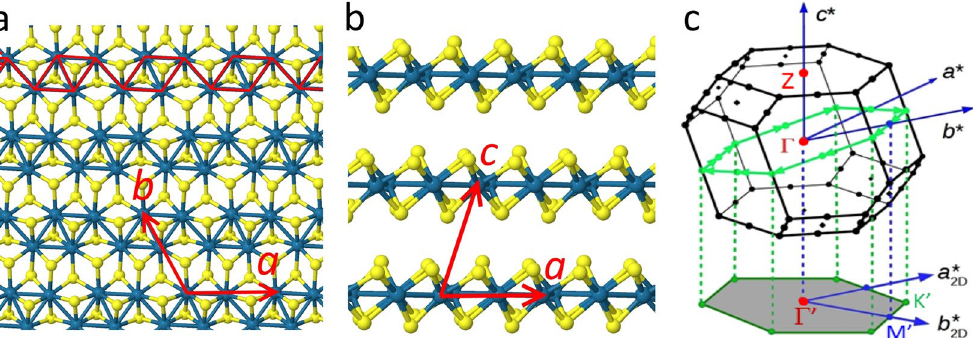
Figure 1. Crystal structure and first Brillouin zone of triclinic ReSe 2 . ( a ) View of a single layer seen from above and ( b ) from the side. Re atoms are coloured blue and Se atoms are yellow. The directions of the lattice vectors a , b and c are indicated; a is defined here as the direction of the rhenium chains, highlighted in red in ( a ). ( c ) First Brillouin zone of ReSe 2 indicating the reciprocal lattice vectors a * , b * and c * and the conventional points Γ (0, 0, 0) and Z (0, 0, ± ½). The tilted green hexagon indicates a path in reciprocal space around points of the type ( ± ½, 0, 0); the lower gray hexagon shows the pseudo-Brillouin zone defined by the projections of these points onto the real space layer plane, with basis vectors labelled ⁎ a and ⁎ b and centre Γ D 2 D 2